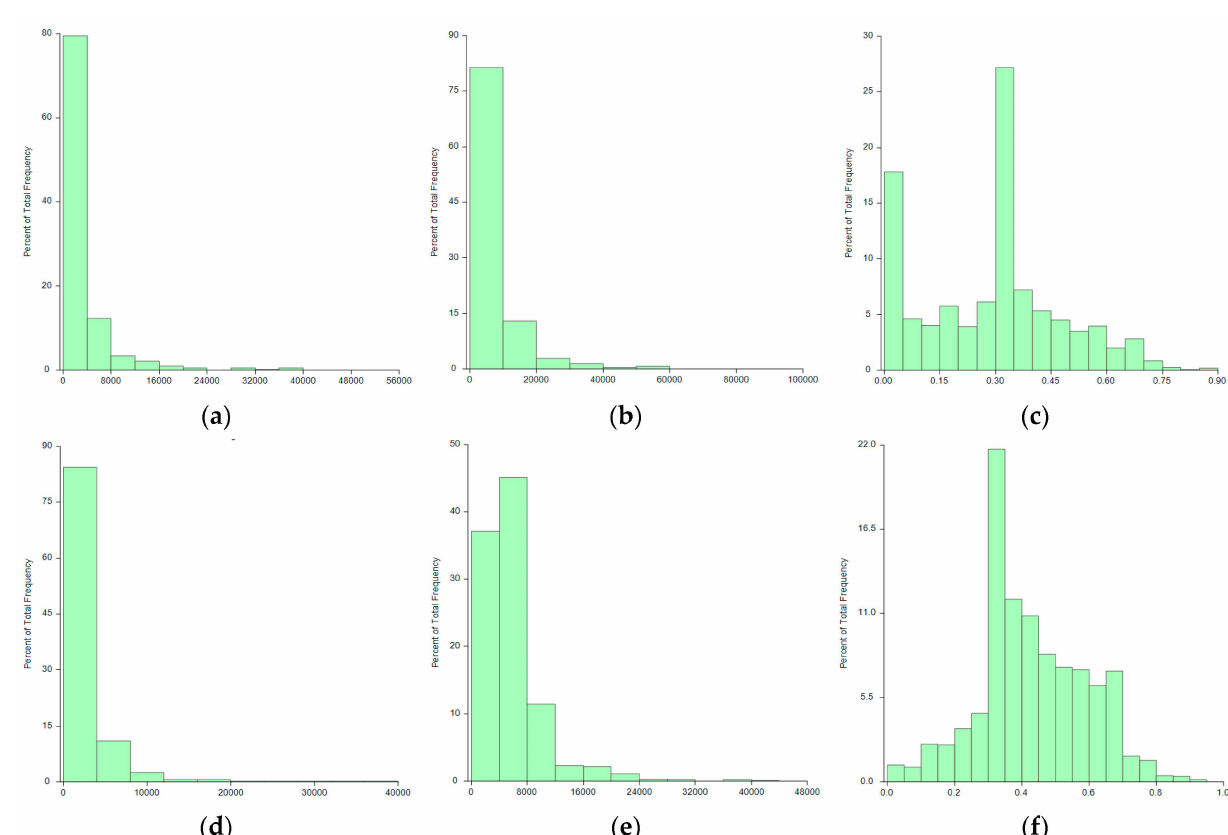
Figure 1. The histograms of six types of choice alternatives: ( a ) Net house density at block level; ( b ) net population density at block level; ( c ) land-use mix index within 0.25-mile buffer; ( d ) net house density at tract level; ( e ) net population density at tract level; ( f ) land-use mix index within 0.5-mile